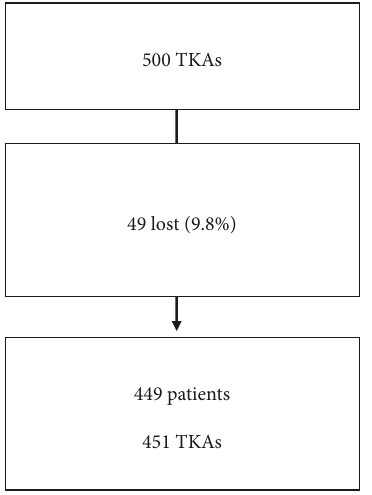
Figure 1: Flow diagram demonstrating patient attrition.